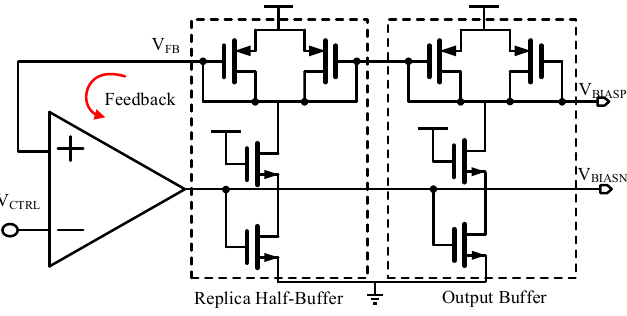
Figure 4. The architecture of the self-bias circuit.